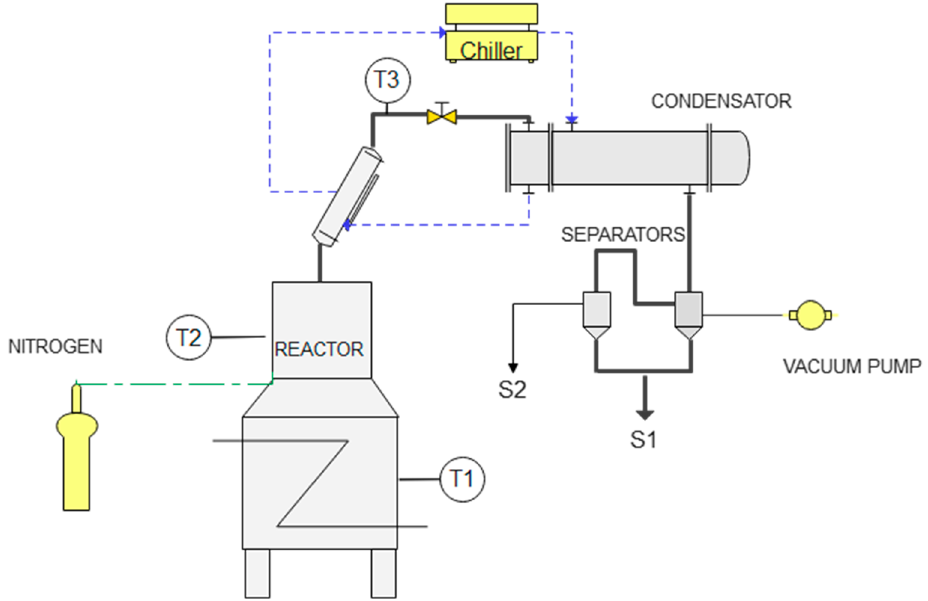
Figure 1. View of the pyrolysis reactor. Table 1. Main characteristics of the reactor.